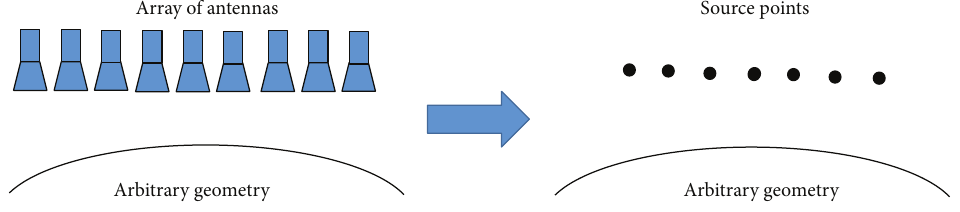
Figure 2: Discretization of a generic array of